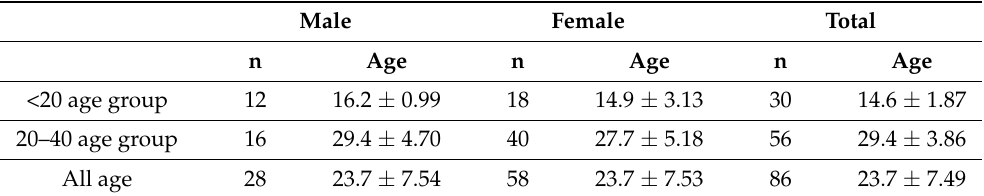
Table 1. Age and sex demographics of the participants.